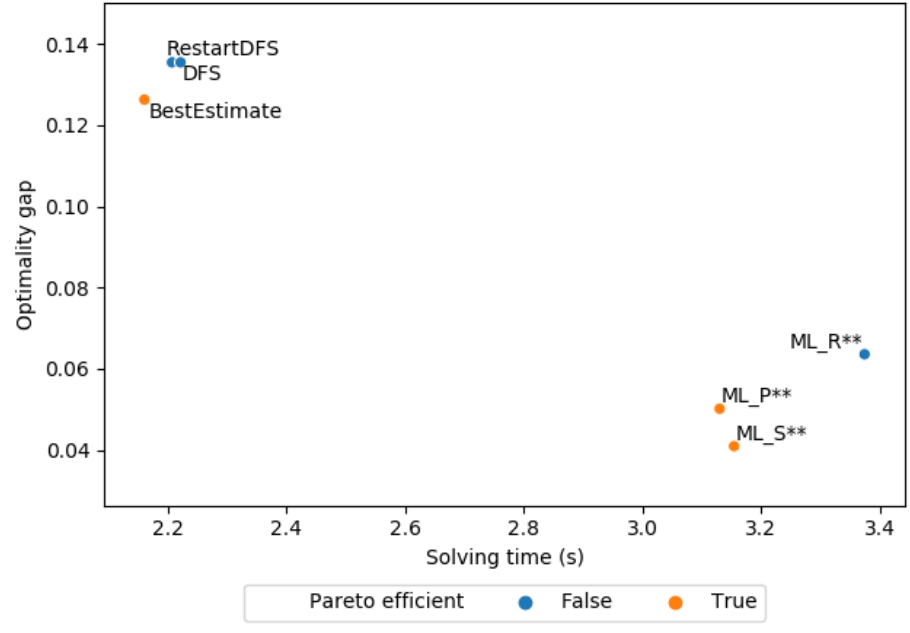
Figure 3. Set cover: mean solving time vs. mean optimality gap of the first solution found at a leaf node. Orange points are Pareto-efficient, blue are not. ‘**’ p <